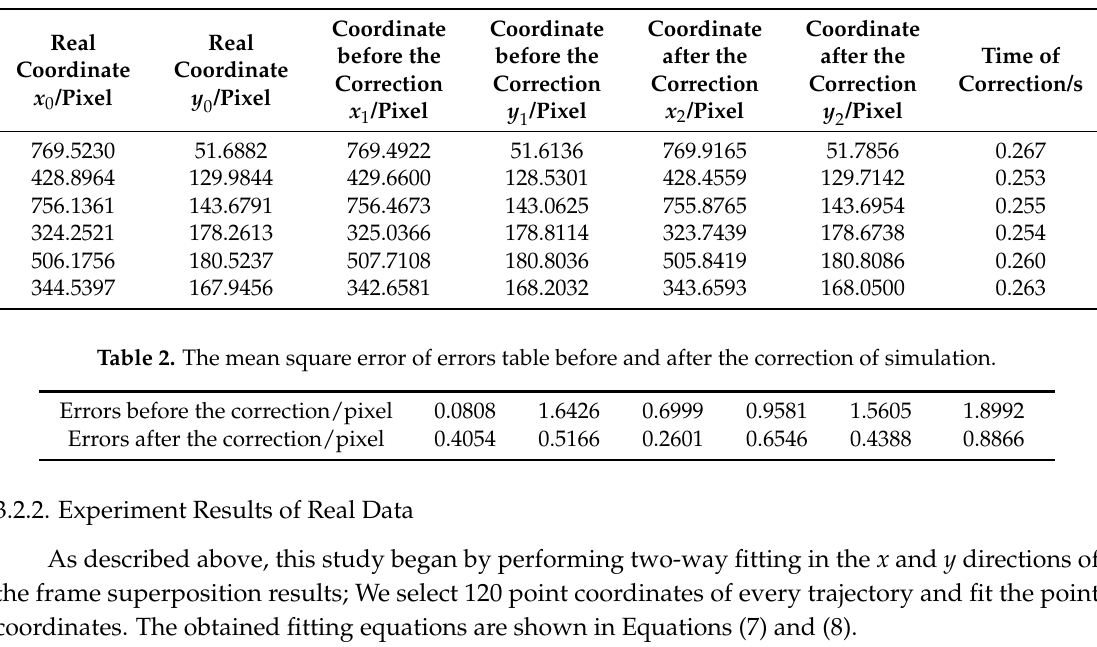
Table 1. The coordinate comparison table before and after the correction of simulation data. Real Coordinate x 0 /Pixel